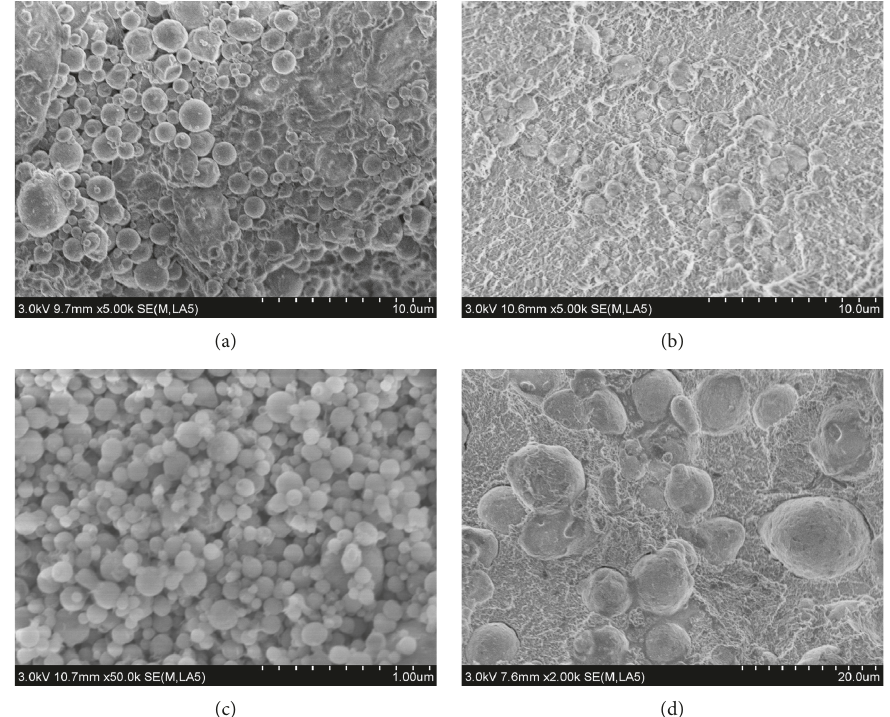
Figure 3: The internal microstructures of specimens. (a) Specimen #2 before sintering. (b) Specimen #2 after sintering. (c) Specimen #1 after sintering. (d) Specimen #4 after